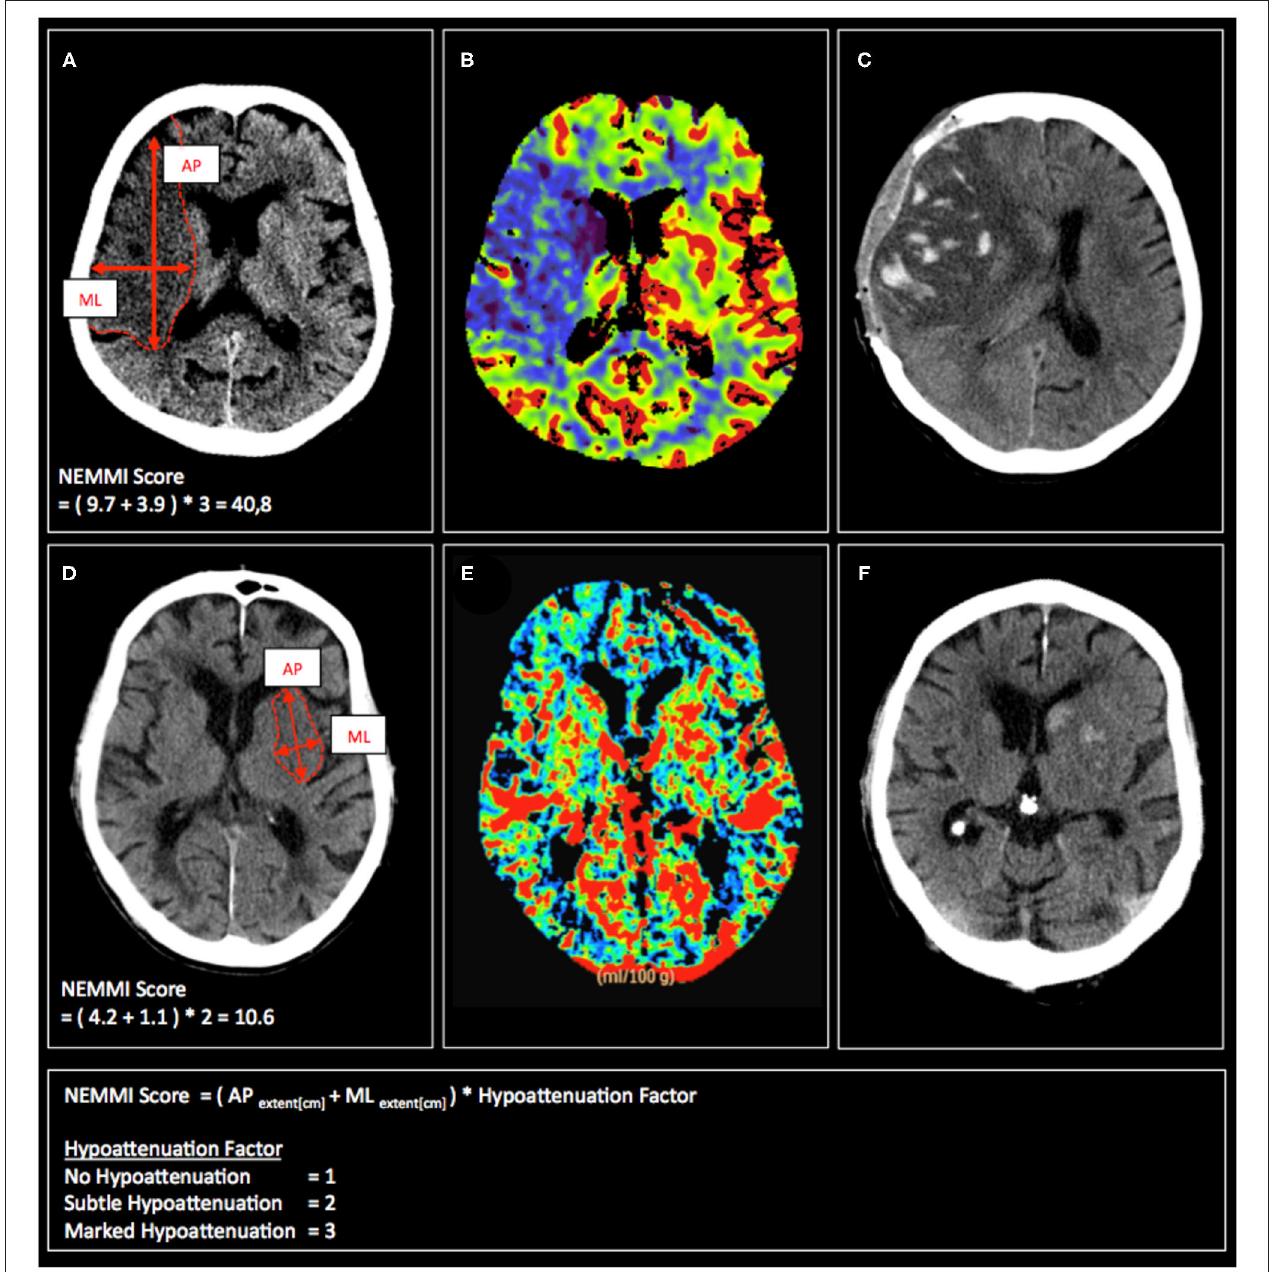
FIGURE 1 | Exemplary admission CT scans (A,D) , CBV maps (B,E) , and follow-up CT scans (C,F) of patients with acute MCA occlusion, who subsequently develop malignant infarction (upper row) or have a non-malignant clinical course (lower row). Calculation of the respective NEMMI scores as the sum of the maximum AP and ML early lesion diameter multiplicated by the visual hypoattenuation factor is depicted in (A,D) .